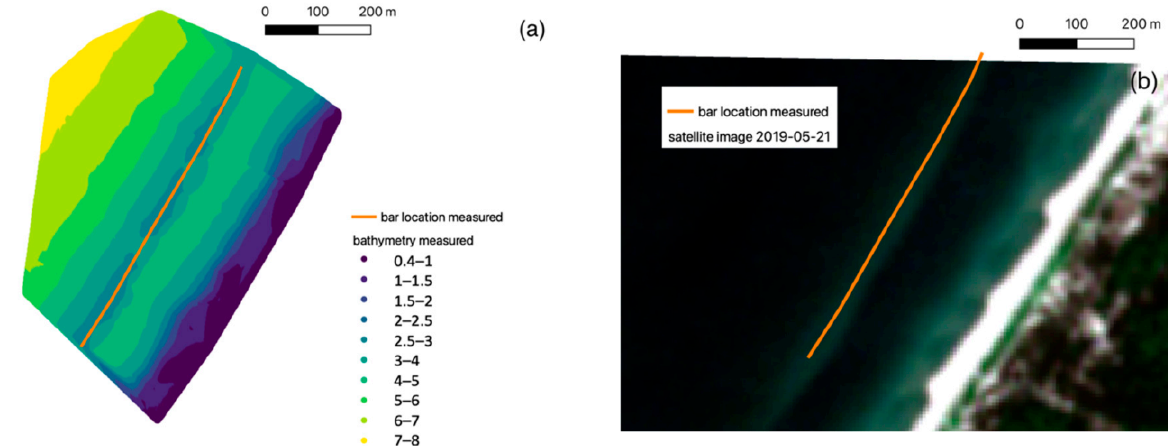
Figure 2. Sand bar crest position detected ( a ) with field measurement (23 May 2019) data ( b ) in the satellite image (Sentinel-2) captured on 21 May